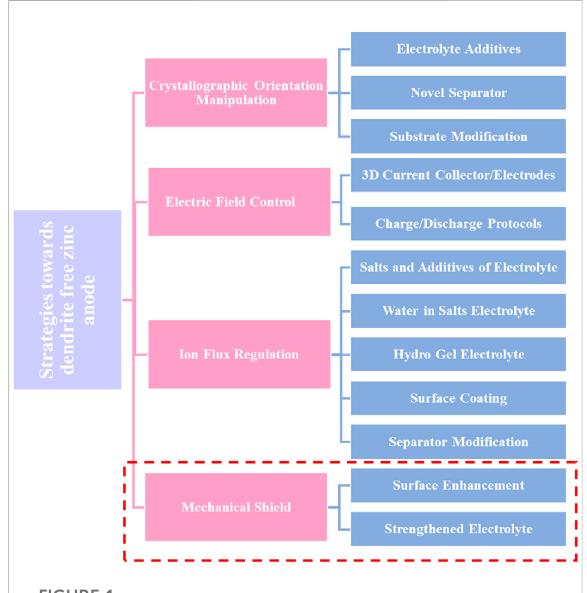
FIGURE 1 Schematic representation of the materials used in RZIBs to stabilize Zn anodes. Reproduced under the terms of the CC-BY CreativeCommonsAttribution4.0Internationallicense(Q.Lietal., 2020). Copyright (2022), Energy